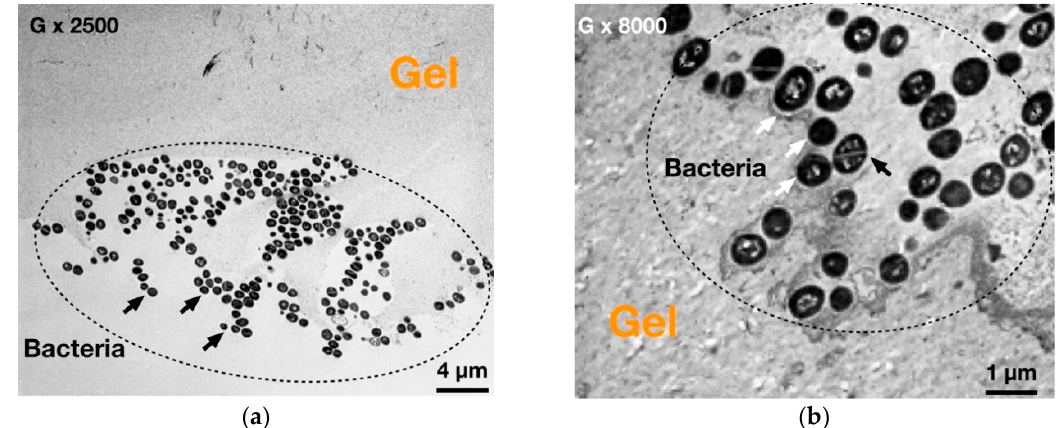
Figure A3. TEM views of Alg–Cat gel surface contaminated with P . gingivalis. ( a , b ) Bacteria colonize the surface of the gel and porous structure, but do not grow inside gel.